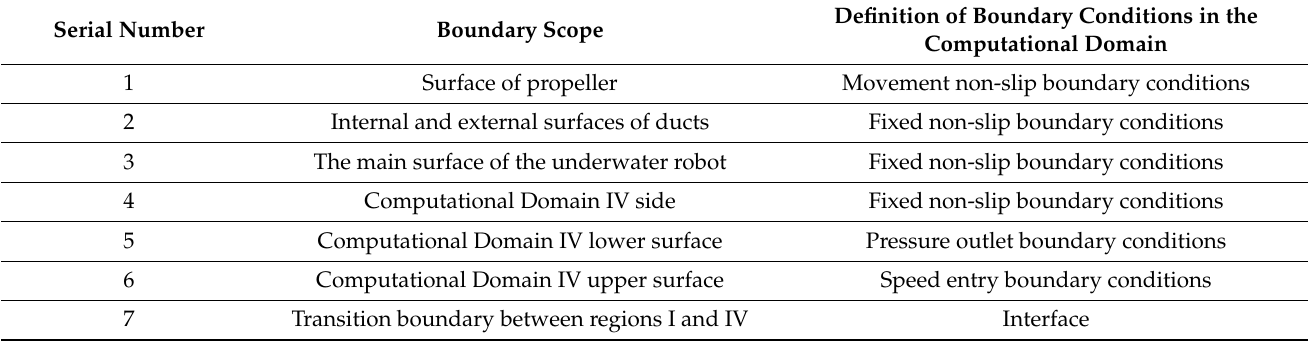
Table 8. Boundary conditions of the underwater robot system.